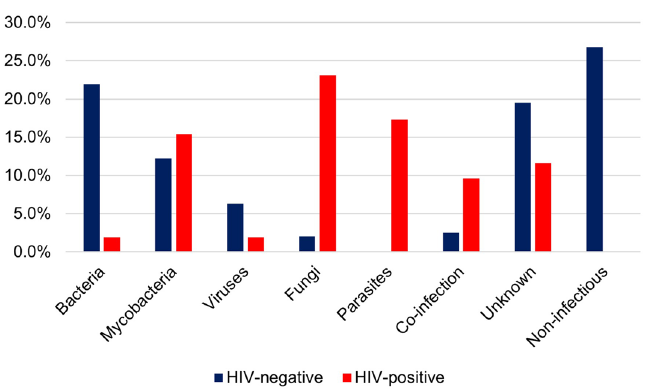
Table 2. Demographics and HIV status of patients suspected of central nervous system infection by aetiologies. Bolivia, 2017–2018. Data are presented as number (%). a K. pneumoniae (n = 6) , A. baumannii (n = 4) , P. aeruginosa (n = 2) , S. aureus (n = 2), Streptococcus spp. (n = 2), E. coli (n = 2) , S. pyogenes (n = 1) , E. faecium (n = 1) S. epidermidis (n = 1) , Achromobacter spp. (n = 1), S. maltophilia (n = 1), Staphylococcus spp. (n = 1); b Acinetobacter spp. (n = 1), Burkholderia spp. (n = 1) , Pseudomona spp. (n = 1), S. epidermidis (n = 1).